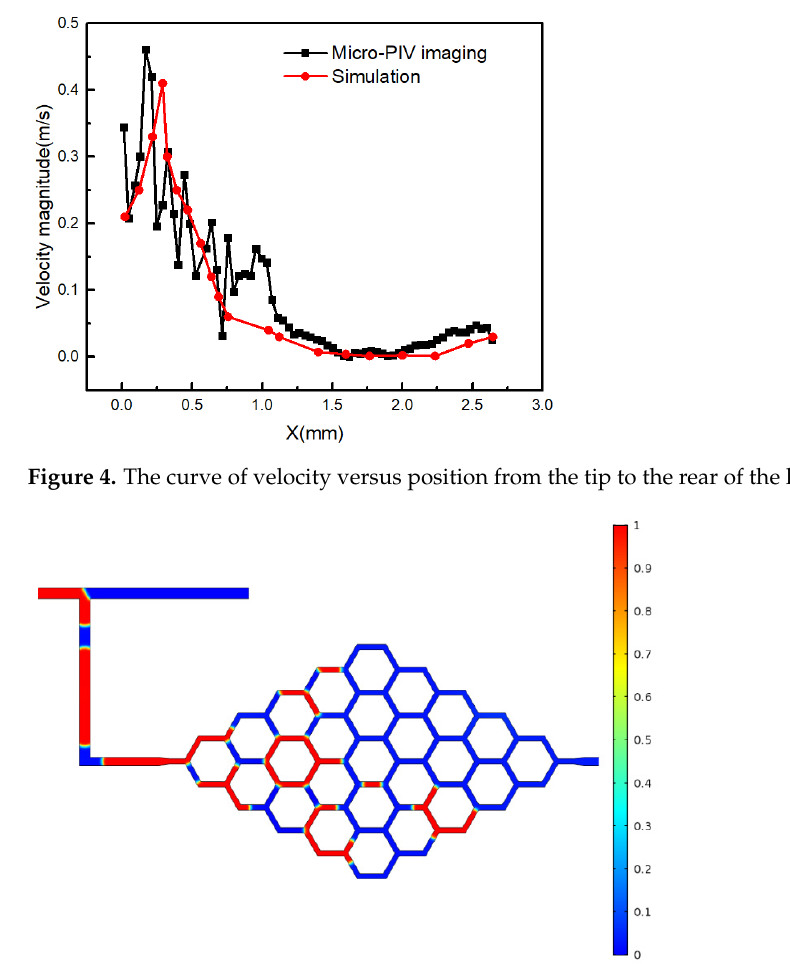
Figure 5. Gas volume fraction distribution contour under condition 3 (t = 7 s).